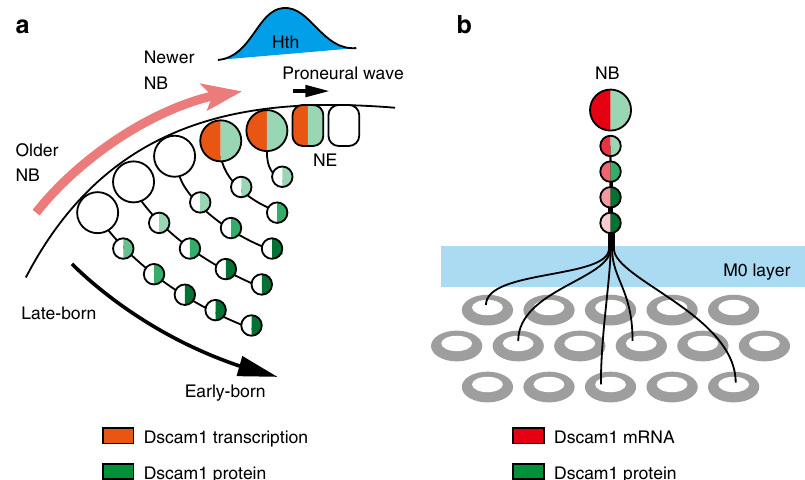
Fig. 7 Inheritance of Dscam1 mRNA and Dscam1 protein, and lineage depend repulsion. Schematics of Dscam1 transcription in NEs and newer NBs under the control of Hth behind the proneural wave ( a ). Graded distribution of Dscam1 mRNA and Dscam1 protein in neurons of the same lineage that controls lineage-dependent repulsion within M0 layer and innervation to different columns ( b